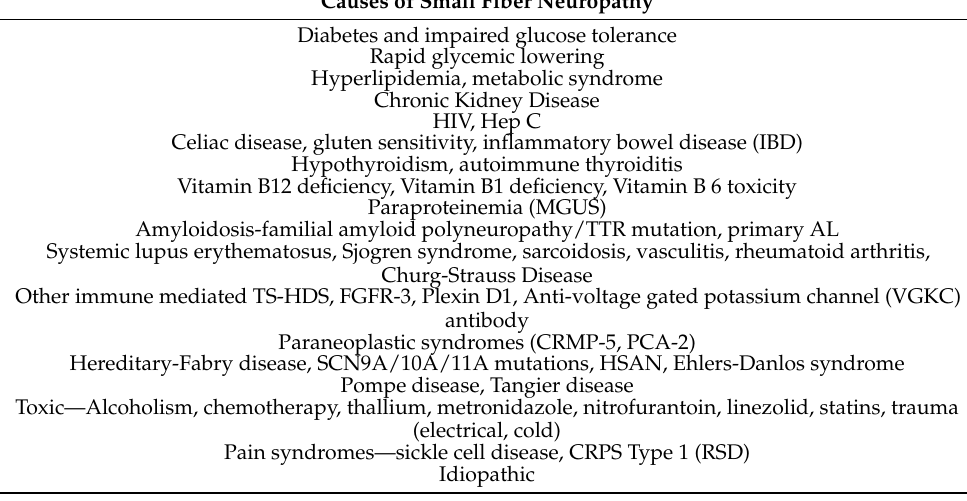
Table 1. Causes of Small Fiber